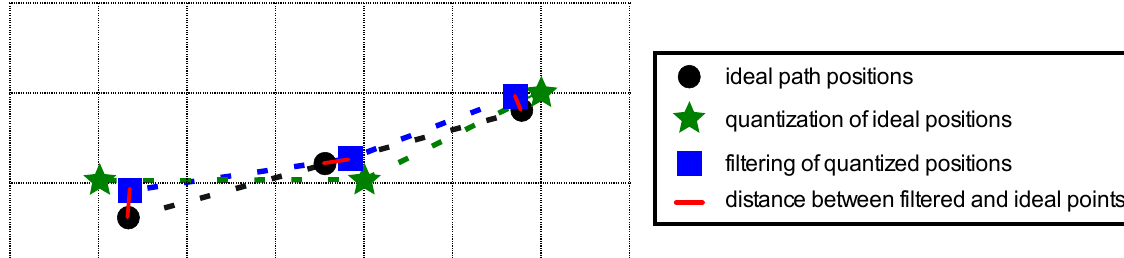
Figure 8. Illustration of the quantization and Kalman filter process conducted over an ideal sample trajectory. The RMSE is defined, according Equation (13), as the square root of the average of all the distances squared with respect to the real reference path